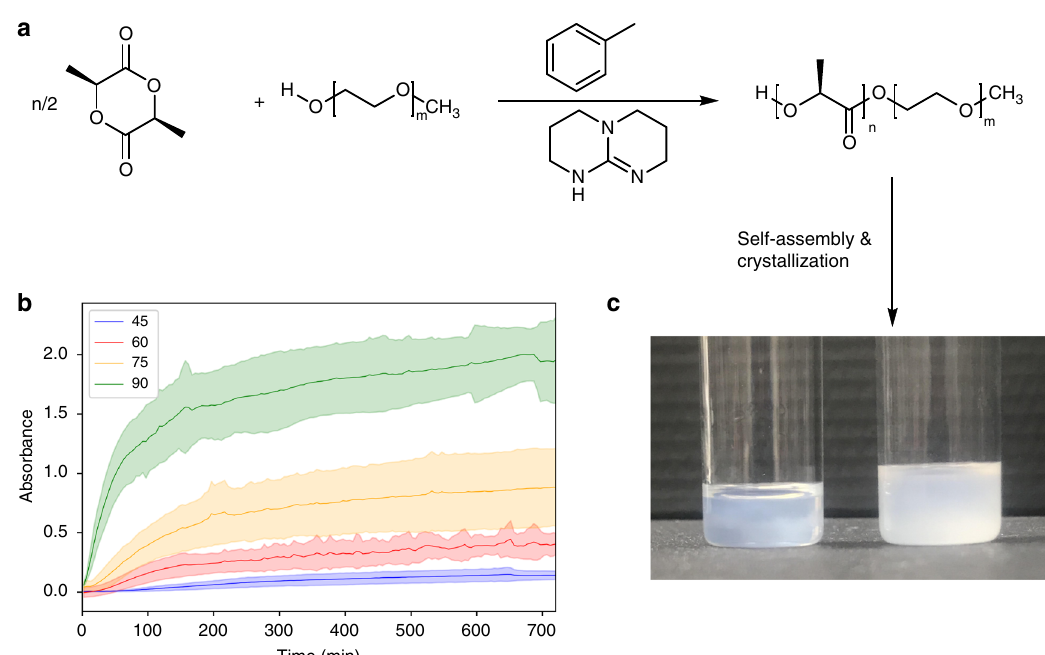
Fig. 1 ROPI-CDSA scheme and self-assembly kinetics. a ROPI-CDSA scheme. b Turbidity measurements (UV/Vis 600 nm) for PLLA DP 45, 60, 75, and 90 at 10% solids w/w, with PEG DP 45 standard error calculated from 3 runs. The data show that the self-assembly kinetics vary as a function of PLLA DP, where increasing DP results in a faster rate of self-assembly. c Photographs showing the difference in turbidity for samples 9 (PLLA 45 - b -PEG 45 10% solids w/w left) and 15 (PLLA 90 - b -PEG 45 10% solids w/w right). Table 1 Molecular characterization of PLLA- b -PEG BCPs synthesized via